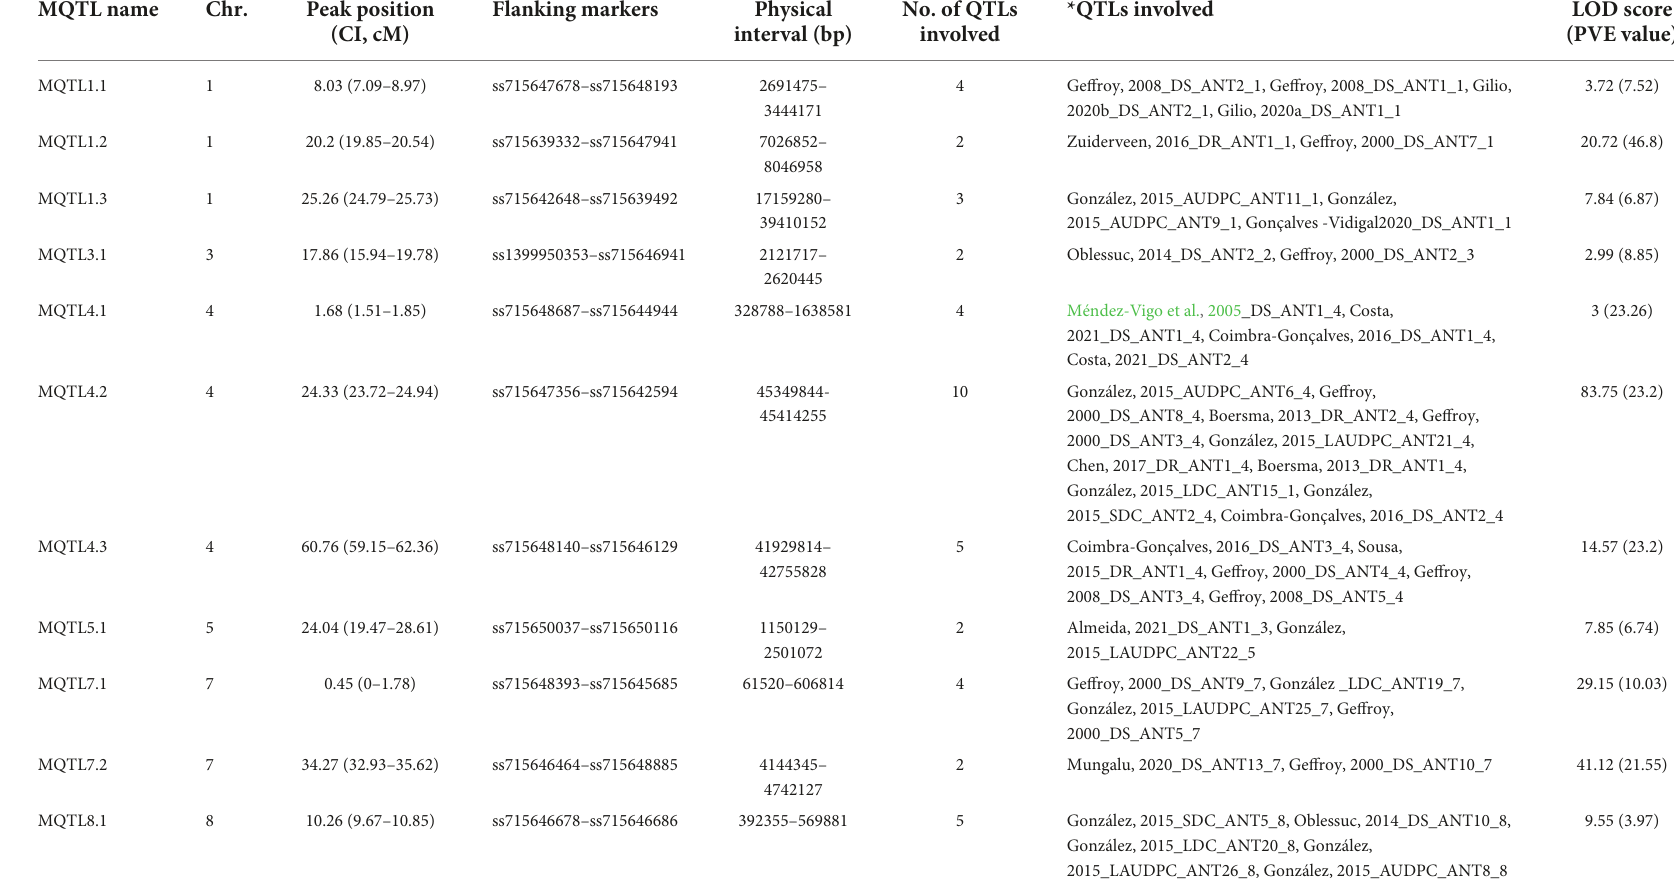
TABLE 2 Details of 11 Meta-QTLs (MQTLs) identified for anthracnose disease resistance in common